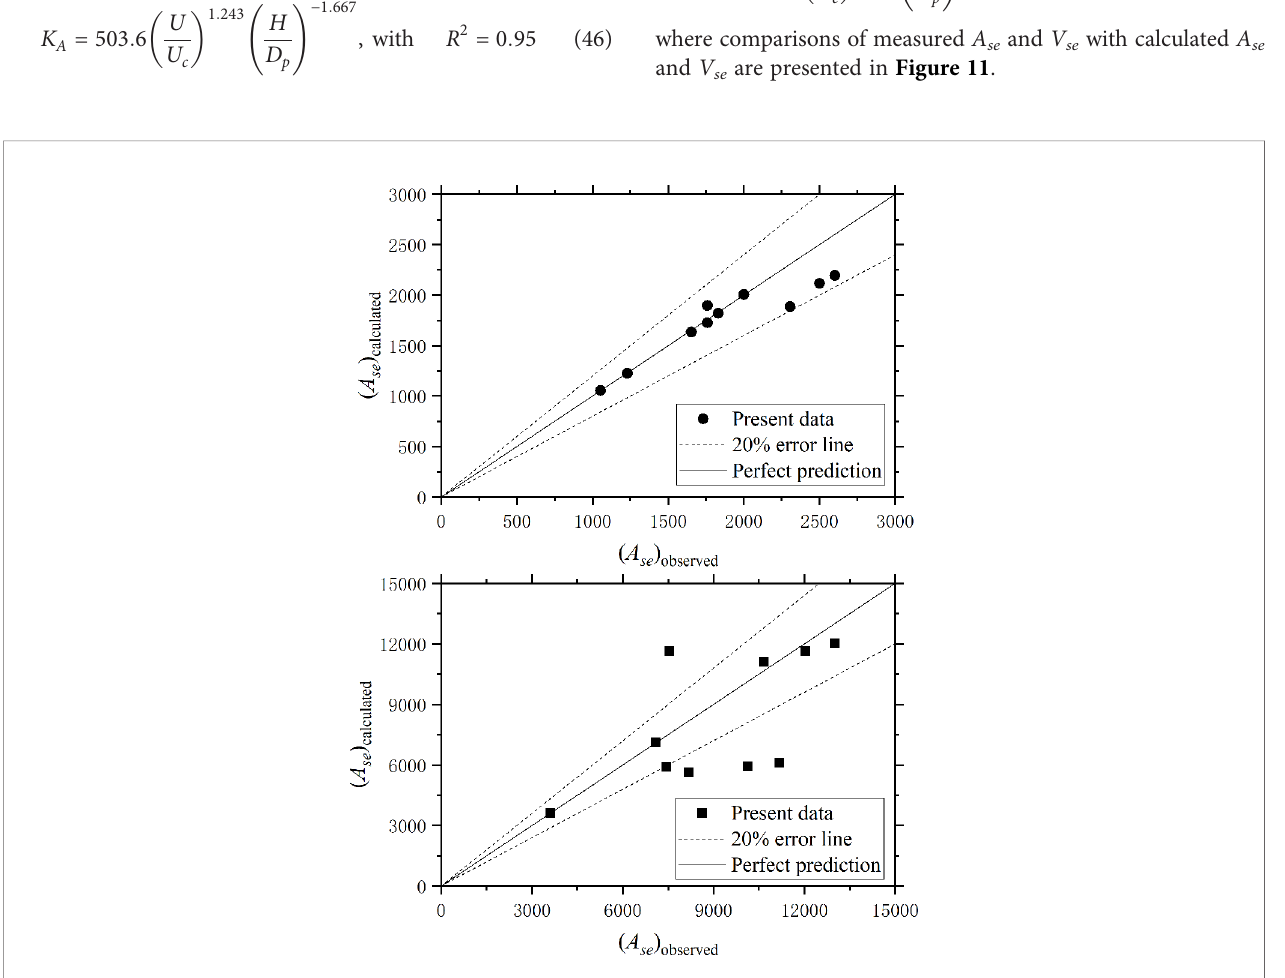
FIGURE 11 | Comparison between observed and calculated value: (A) A se ; (B) V se .